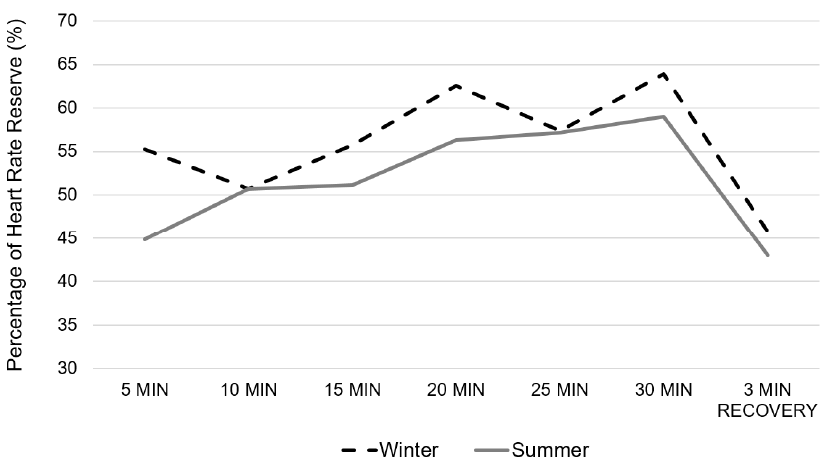
Figure 1. Evolution of the percentage of Heart Rate Reserve during the Aqua walking training session performed either during wintertime (dotted black line) or summertime (full grey line).